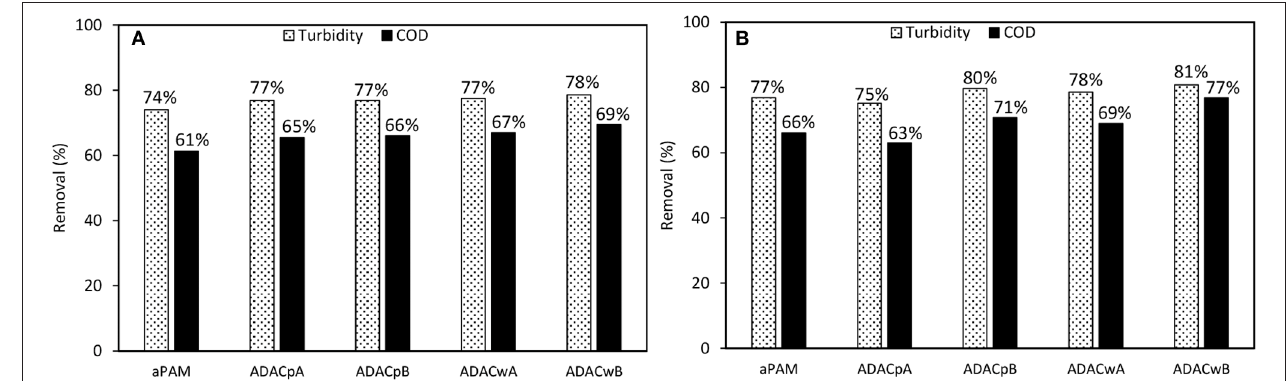
FIGURE 11 | COD reduction and turbidity removal during the industrial effluent treatment with ADAC p A, B and ADAC w A, B and reference aPAM, at pH 3.0, after 24h of treatment, in two conditions: (A) 0.3 wt% bentonite followed by 2.67 mg/L of flocculation agent and (B) 0.6 wt% bentonite followed by 5.34 mg/L of flocculation